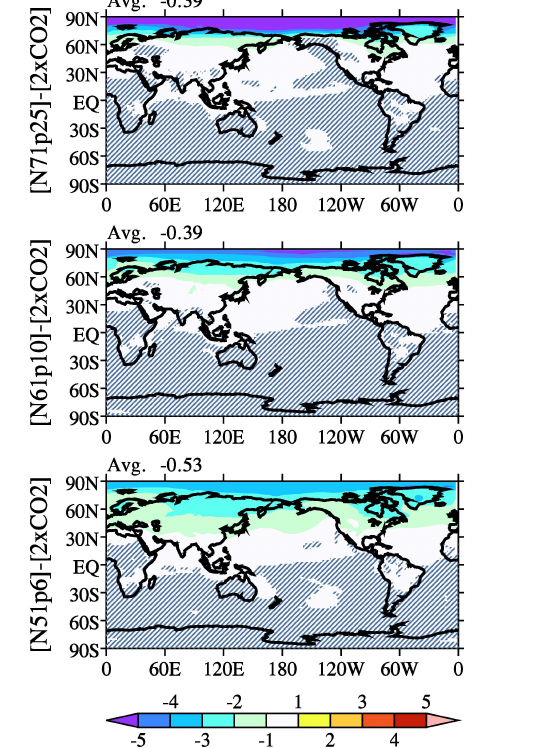
Fig. 2. Model-calculated changes in annual-mean surface air tem- perature (in Kelvins) from the doubled-CO 2 baseline as a result of imposing northern high-latitude solar reductions of 3 different lat- itudinal extents on a CO 2 doubled climate. From the top, the solar reductions are 25% north of 71 ◦ N, 10% north of 61 ◦ N, and 6% north of 51 ◦ N. The hatching, mostly in the Southern Hemisphere, covers regions where there is no statistically significant effect, as explained in the caption for Fig.